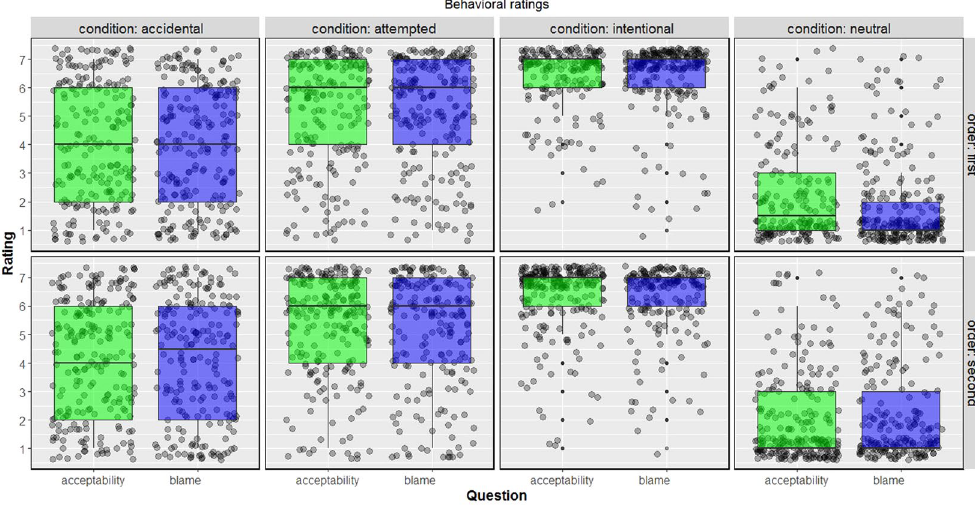
Figure 7. Behavioral results from the fMRI study. Boxplots with jittered data points for moral judgments given by participants in the fMRI study, displayed separately for each order. No outcome-by-judgment interaction was observed in either order. Note that higher ratings on acceptability question mean that the behavior was deemed to be less